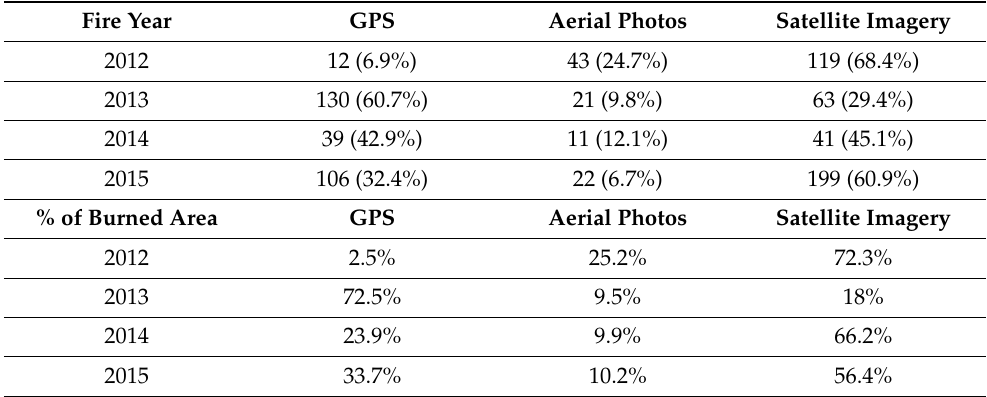
Table 1. Number (and percentage) of wildfires and percentage of total burned area by year and documentation method on Babeldaob Island, Palau, for 2012–2015. All fires after 2015 were mapped using satellite